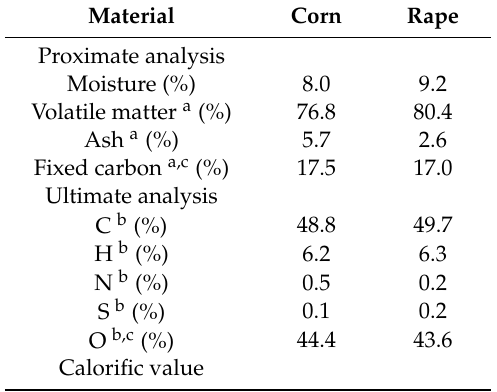
Table 1. Proximate analysis, ultimate analysis, calorific value, and composition of principal components corresponding to the corn and rape used in this